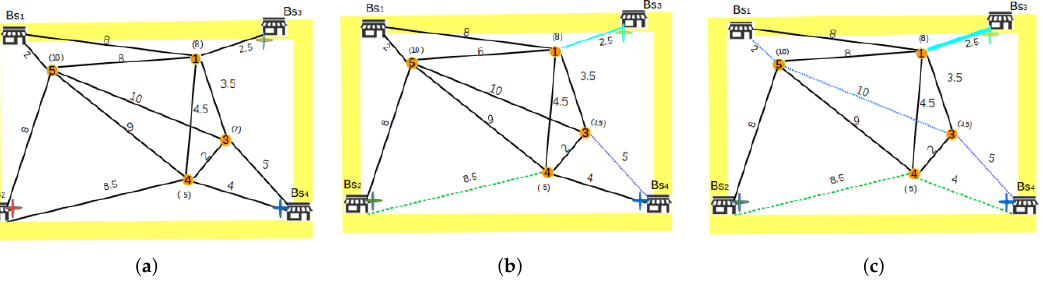
Figure 2. Illustrative example. ( a ) Initial step; ( b ) The best neighbour choice; ( c ) Illustrative